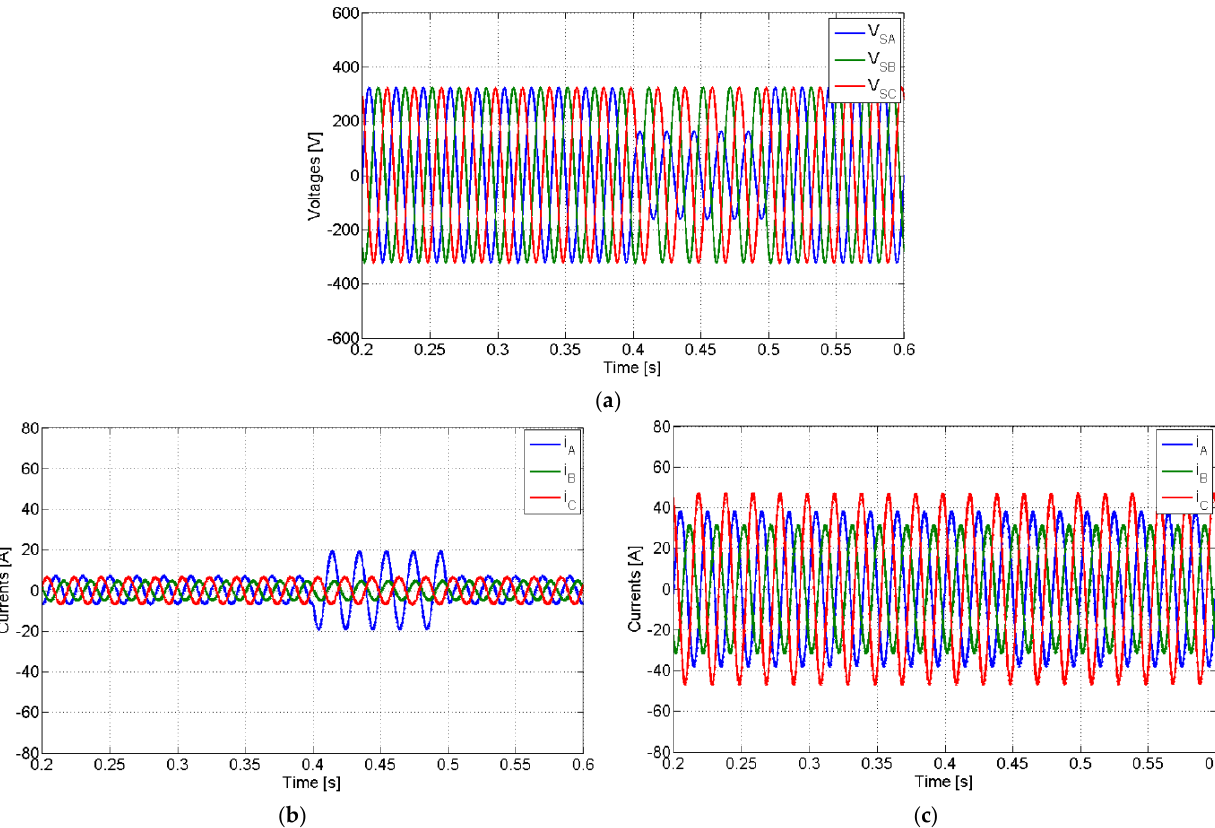
Figure 23. Simulation results for a phase-to-ground fault using a non-linear load and compensation of the active power imbalance: ( a ) grid voltages; ( b ) grid currents; ( c ) AC currents of the PV generator.